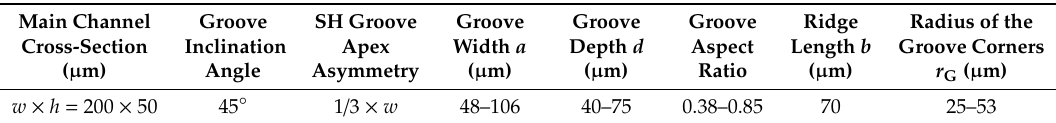
Table 1. Geometrical parameters of simulated micromixer